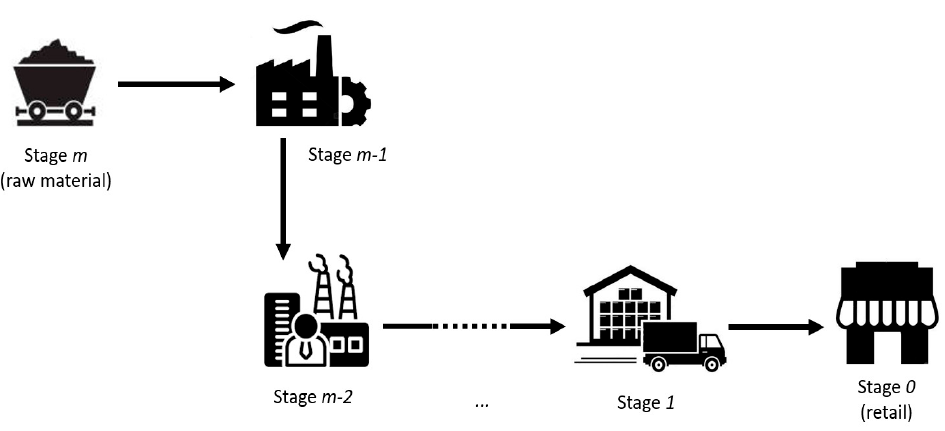
Figure 2. Supply chain with m stages.